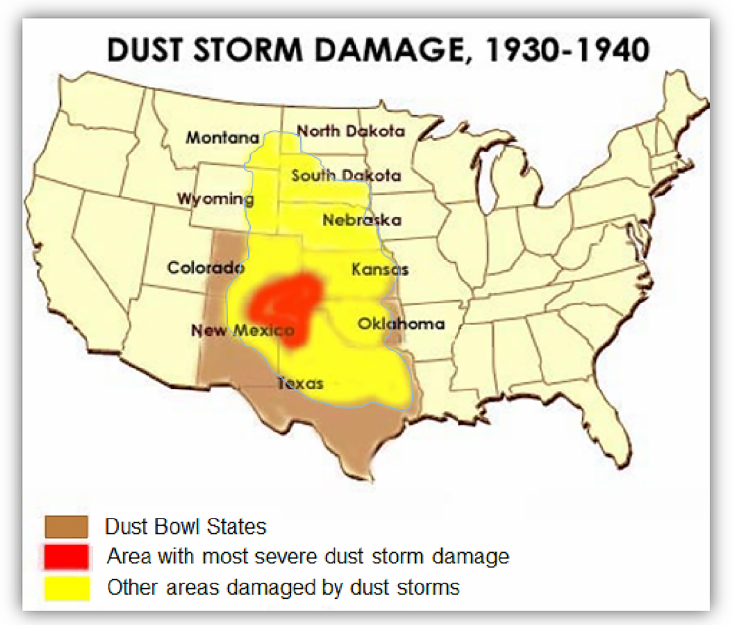
Fig 1. States affected by severedust storm “Dust Bowl” that occurred during the 1930’sto 1940’s. The center of the storm was in Panhandlesof Texas and Oklahoma, but its significanteffect damagedthe neighboring